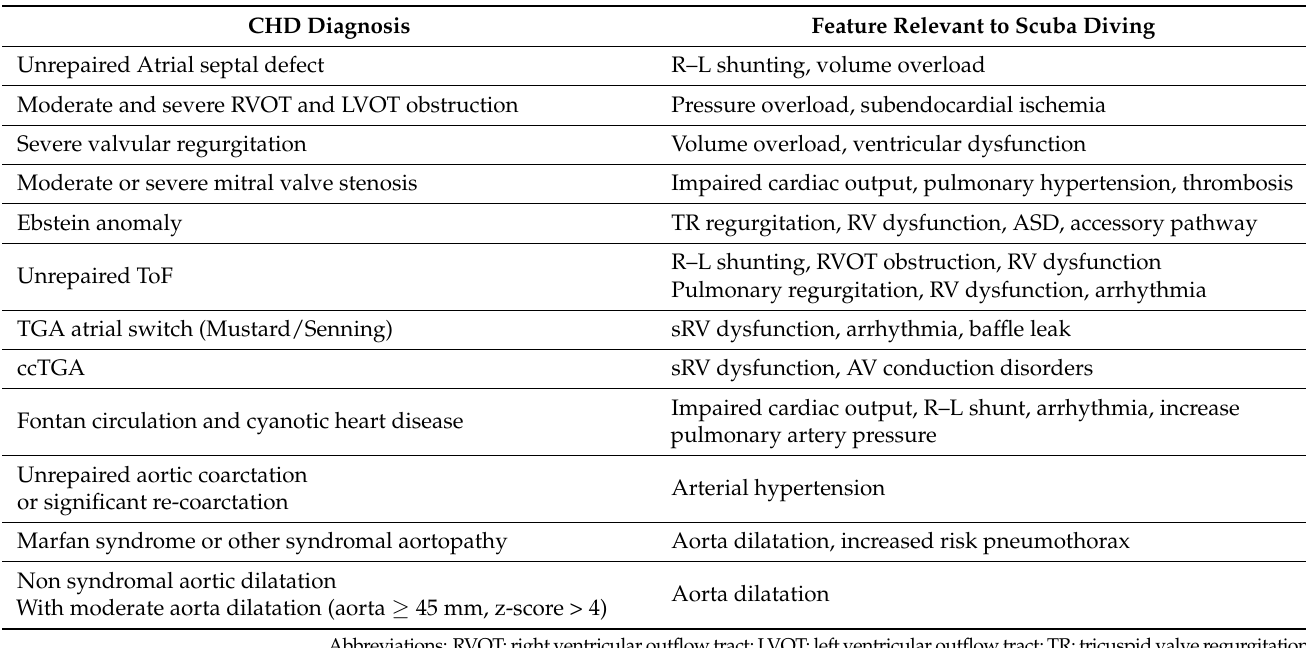
Table 2. CHD diagnoses incompatible with SCUBA